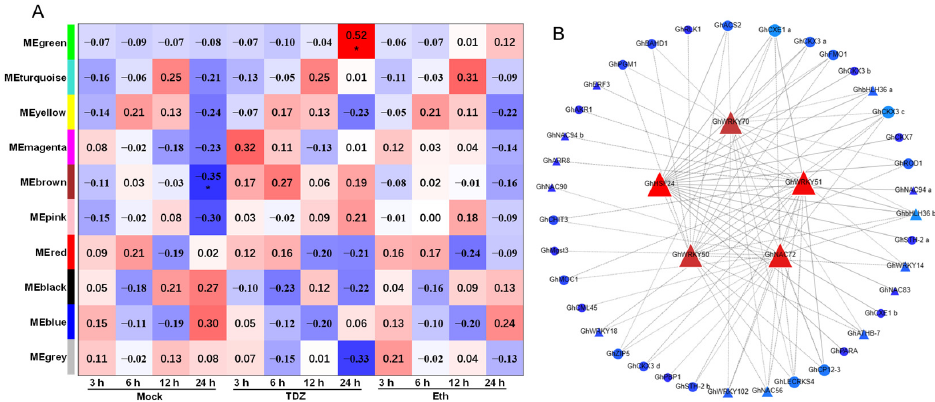
Figure 12. Gene co-expression network analysis by WGCNA. ( A ) Module–sample phenotype associ- ation, * indicates p -value < 0.05. ( B ) Network of Hub transcription factors in green module. Triangles represent transcription factors, circles represent functional genes, red represents hub transcription factors within modules, and blue represents of hub transcription factors target